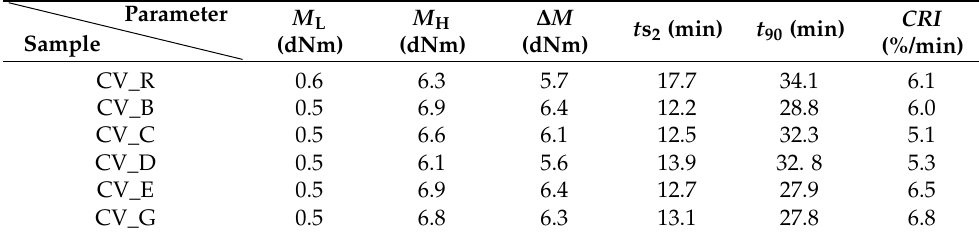
Table 7. Parameters for the vulcanization of rubber compounds produced in the CV system.